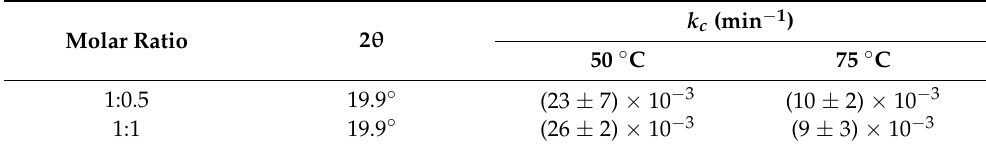
Table 2. Rate constants of PPR crystal formation from XRD for the reaction of PEG400 with α -CD. Molar Ratio 2